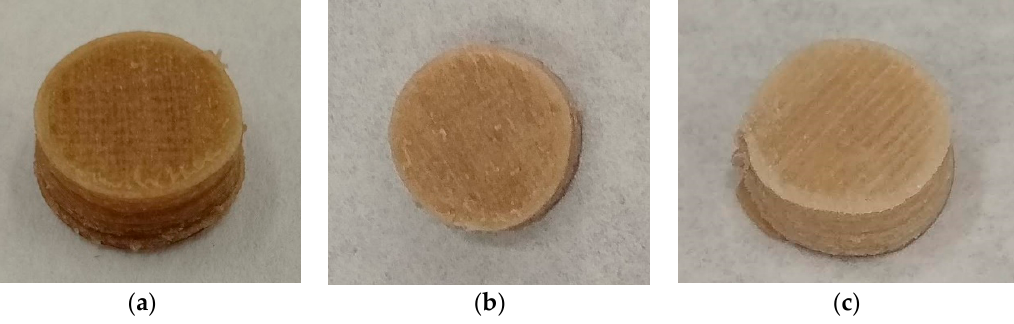
Figure 2. Image of a 3DP tablets made of AFF as main carrier and MET as drug model: ( a ) 30% drug load, ( b ) 40% drug load, and ( c ) 50% drug load.